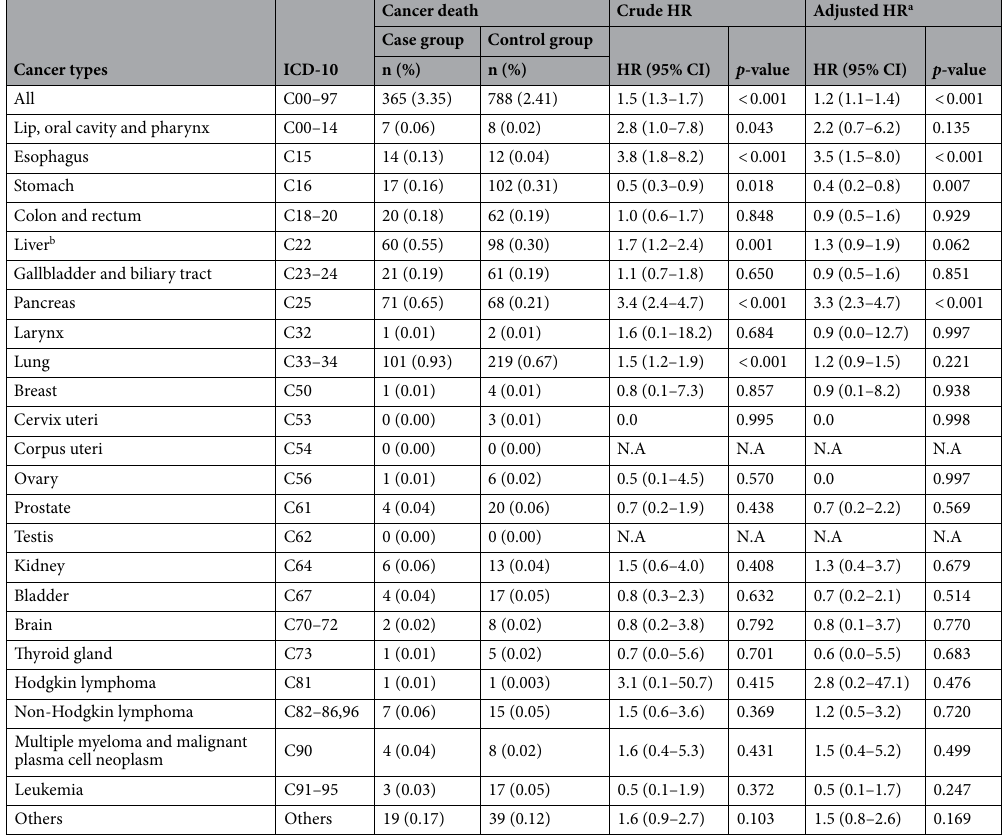
Table 3. Hazard ratios of cancer mortality. a Adjusted hazard ratio was adjusted for smoking status, alcohol consumption, physical activity, body mass index, fasting blood sugar level, total cholesterol level, and Charlson Comorbidity Index. b Liver cancer was additionally adjusted for chronic infection of virus B and C hepatitis (International Classification of Disease 10th edition: B18). N.A. not